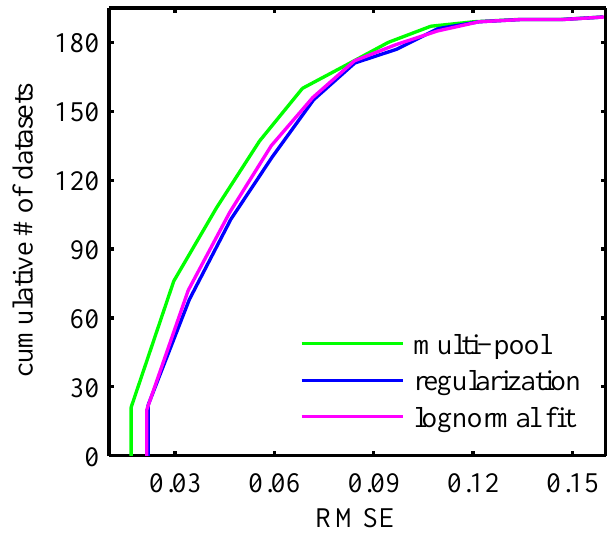
Fig. 5. Comparison of root mean square error (RMSE) associated with the three different parameter estimation procedures. For each one, the RMSE of the predicted decay is calculated for 191 LIDET data sets. The y -axis shows the number of datasets having an RMSE smaller than the value of RMSE on the x -axis. Shown are the RMSE of the unregularized multi-pool solution (green), regularized solu- tion (blue), and two-parameter nonlinear fit